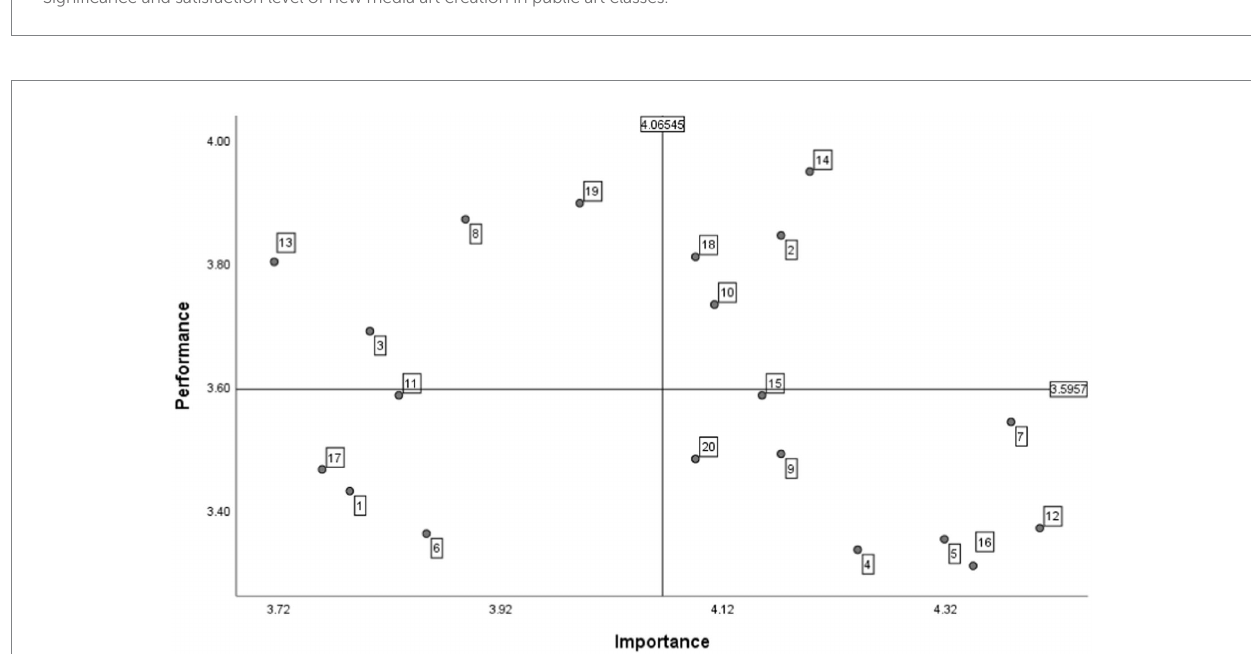
FIGURE 3 Significance and satisfaction level of new media art creation in public art classes.